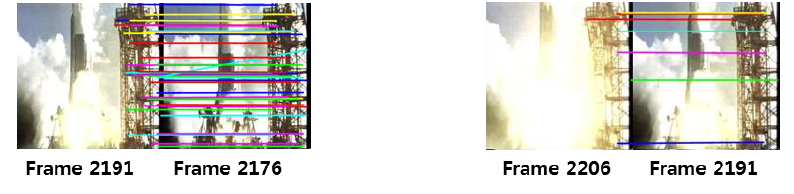
Figure 6. The results of the shot boundary verification.